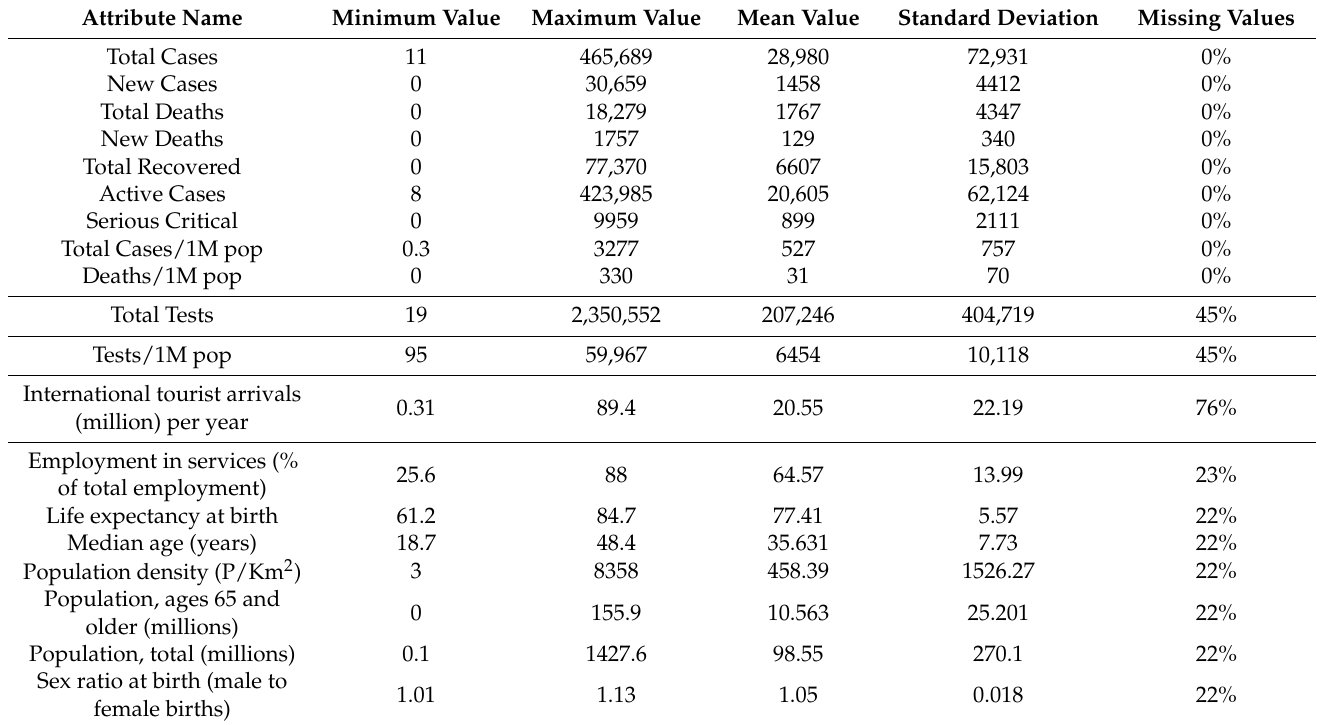
Table 1. The statistical description of the